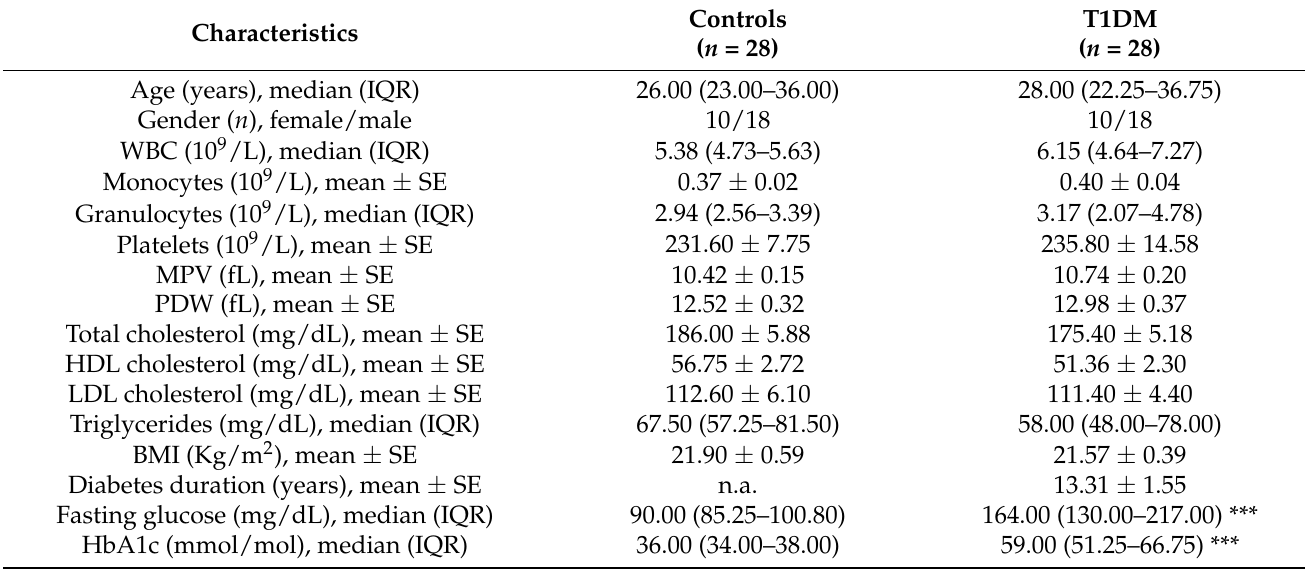
Table 1. Subject